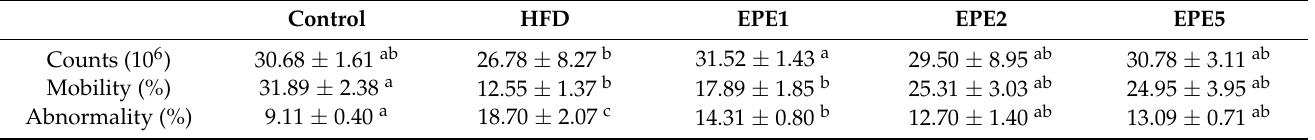
Table 5. Effects of Echinacea purpurea ethanol extract on sperm parameters in HFD-induced obese rats after 5 weeks.